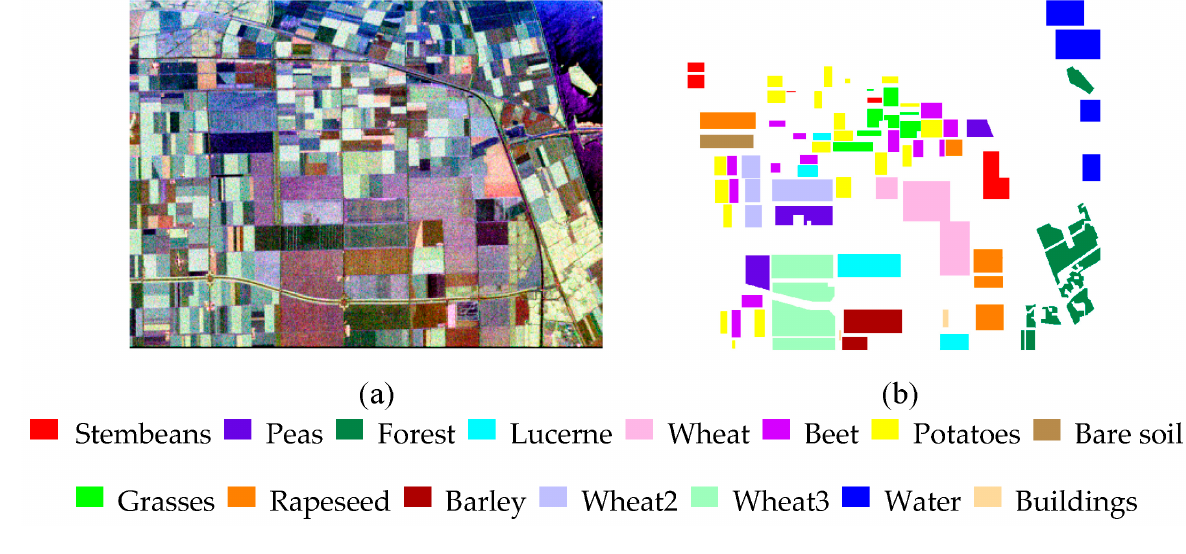
image is shown in Figure 6a and the corresponding ground-truth map of this image is depicted in Figure 6b. Figure 5. AIRSAR dataset in Flevoland I: ( a ) Pauli image. ( b ) Ground-truth image. The second PolSAR dataset is C-band PolSAR data of Flevoland II, the Netherlands, acquired by RADARSAT-2 in 2008, which has 1400 × 1200 pixels. The resolution of this image is 10 5 m m × . It contains four different terrain types. The Pauli RGB map of the